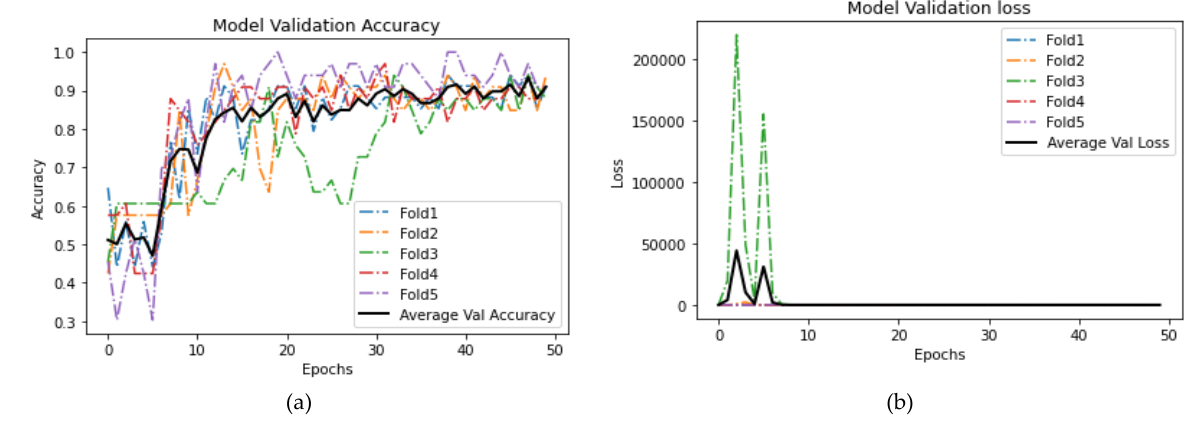
Figure 4. Validation accuracy and loss curve for InceptionResnetV2. ( a ) Model Validation Accuracy; ( b ) Model Validation Loss.